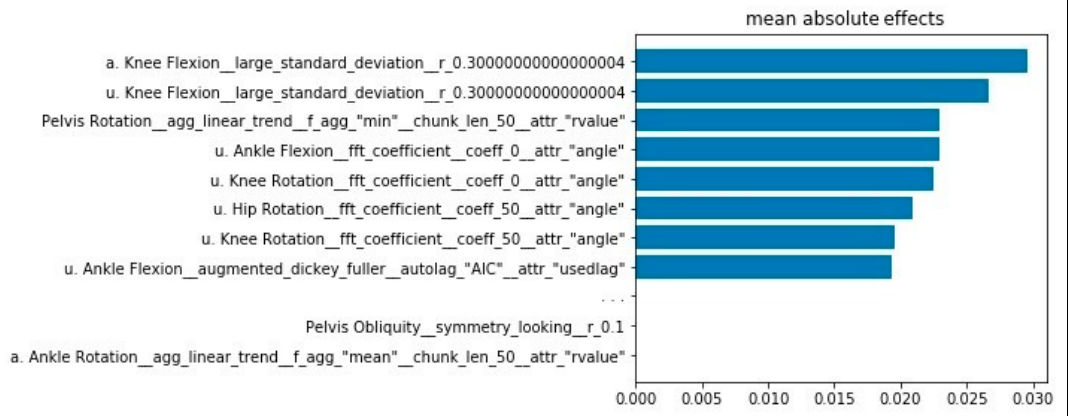
Figure 5. Mean absolute effects for the V_tsfresh input vector determined using LIME. Results are based on SVM linear with MinMaxScaler. Feature labels are according to the automated feature extraction algorithm tsfresh [18].